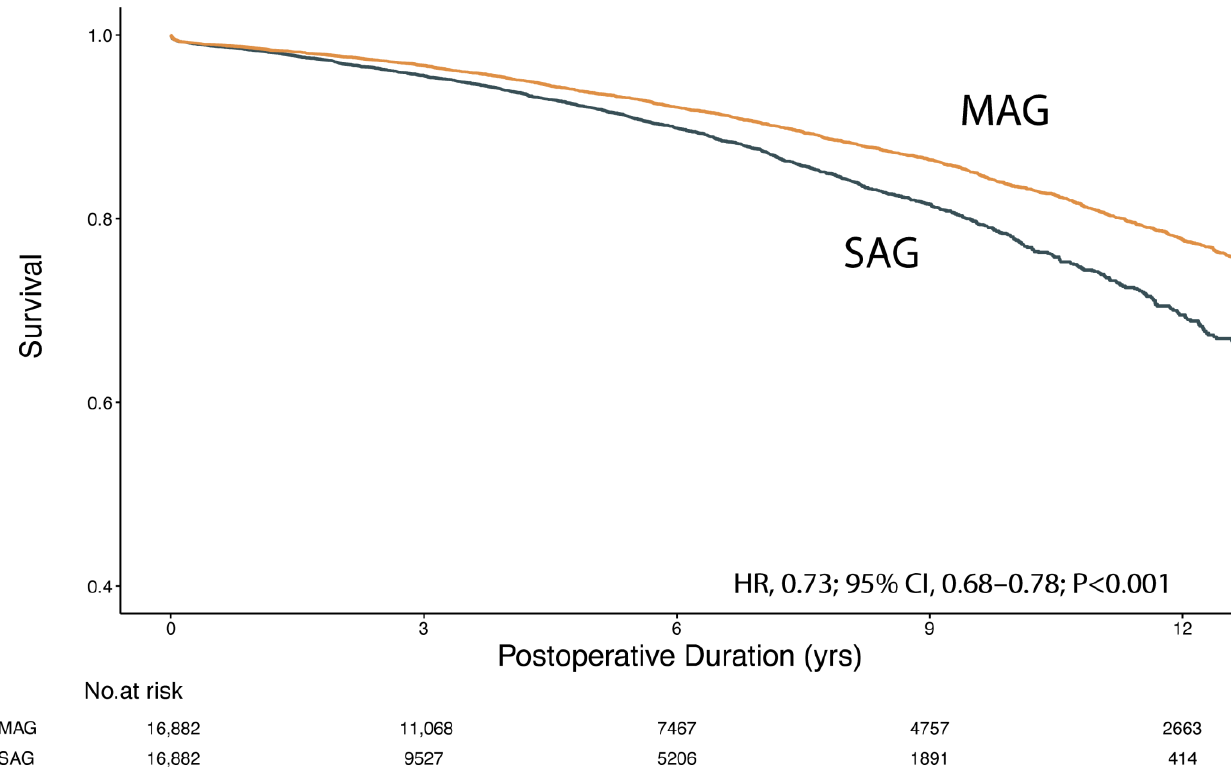
Figure 2. Kaplan–Meier survival curve for MAG vs. SAG in matched cohort <70 years of age. MAG, multiple arterial grafting; SAG, single arterial grafting.